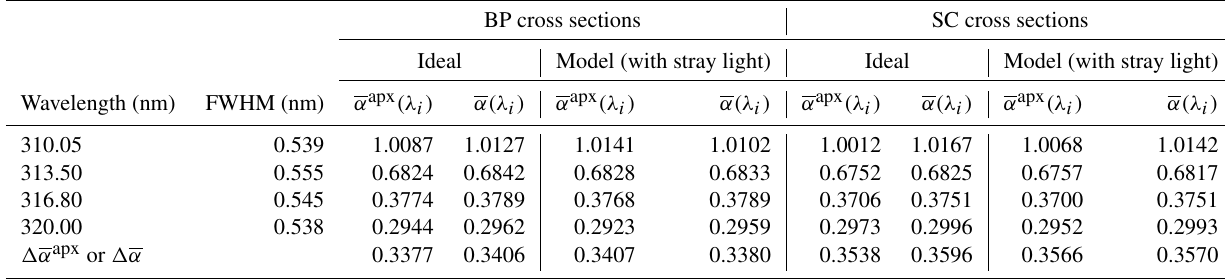
Table 4. Single Brewer ozone absorption coefficients.